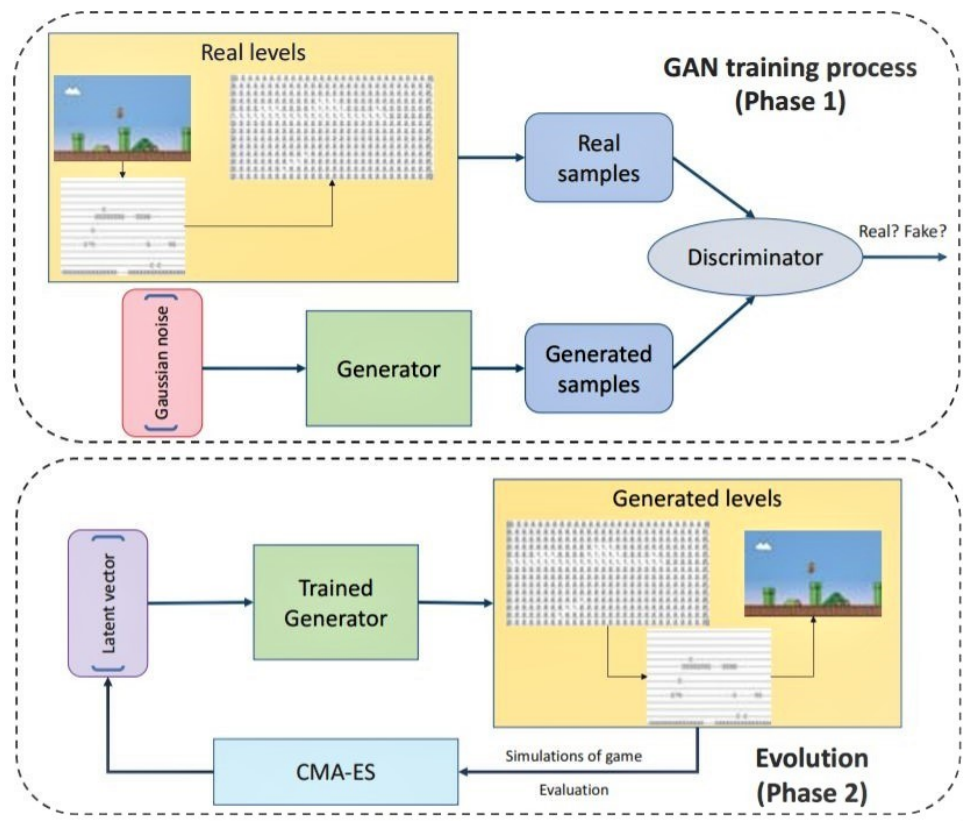
Figure 2. Proposed workflow for classification and validation of